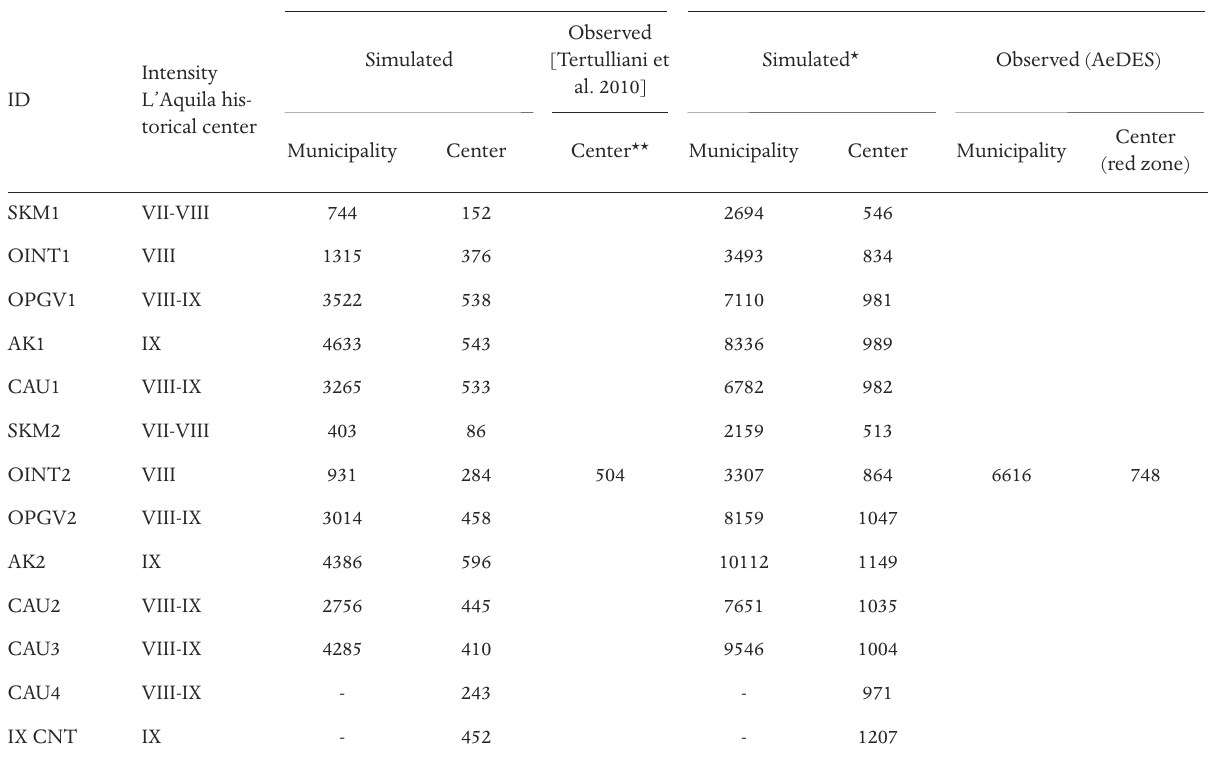
Table 4. Results of the different simulations for the L’Aquila municipality. (*) Transformation based on Table 6 (E=100% of D4 and D5 buildings + 85% of D3 + 47% of D2). (**) Total number of buildings in center of L’Aquila on April 6, 2009, was 1536, according to Tertul- liani et al. [2010]. Total number of buildings considered in this scenario, based on ISTAT [2001], data is 1511. Total number of buildings in red zone (zona rossa) in the center of L’Aquila according to AeDES is